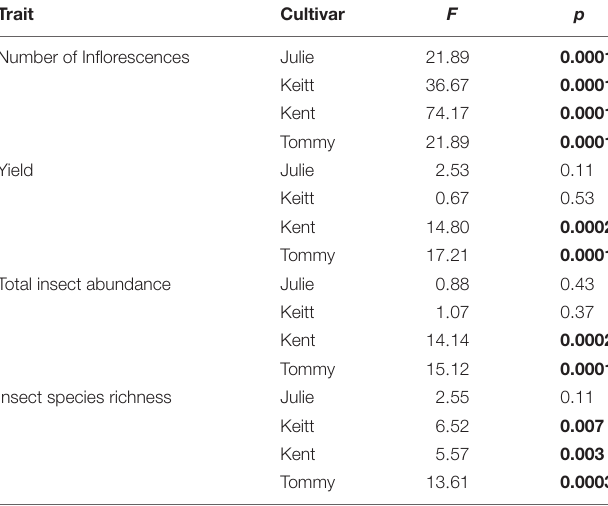
TABLE 3 | Repeated Measures one-way ANOVAs on reproductive traits and insect community traits recorded annually in four fields of M. indica between 2017 and